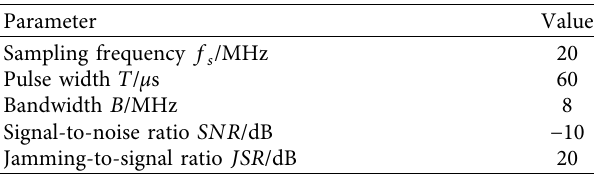
Table 3: Basic parameter settings. Table 4: The settings of four generated